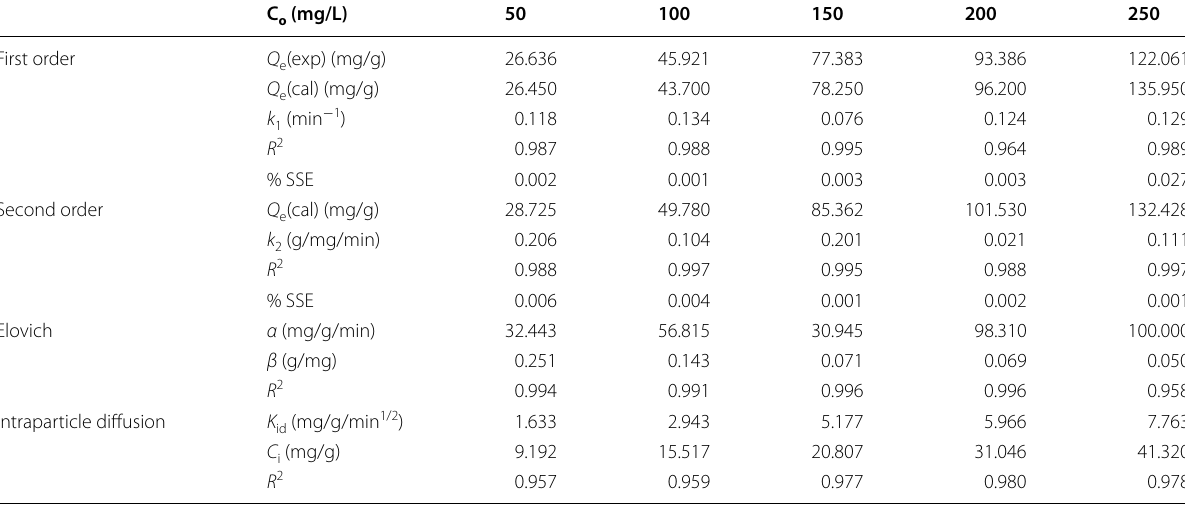
Table 1 Kinetic data values for the adsorption of cadmium by